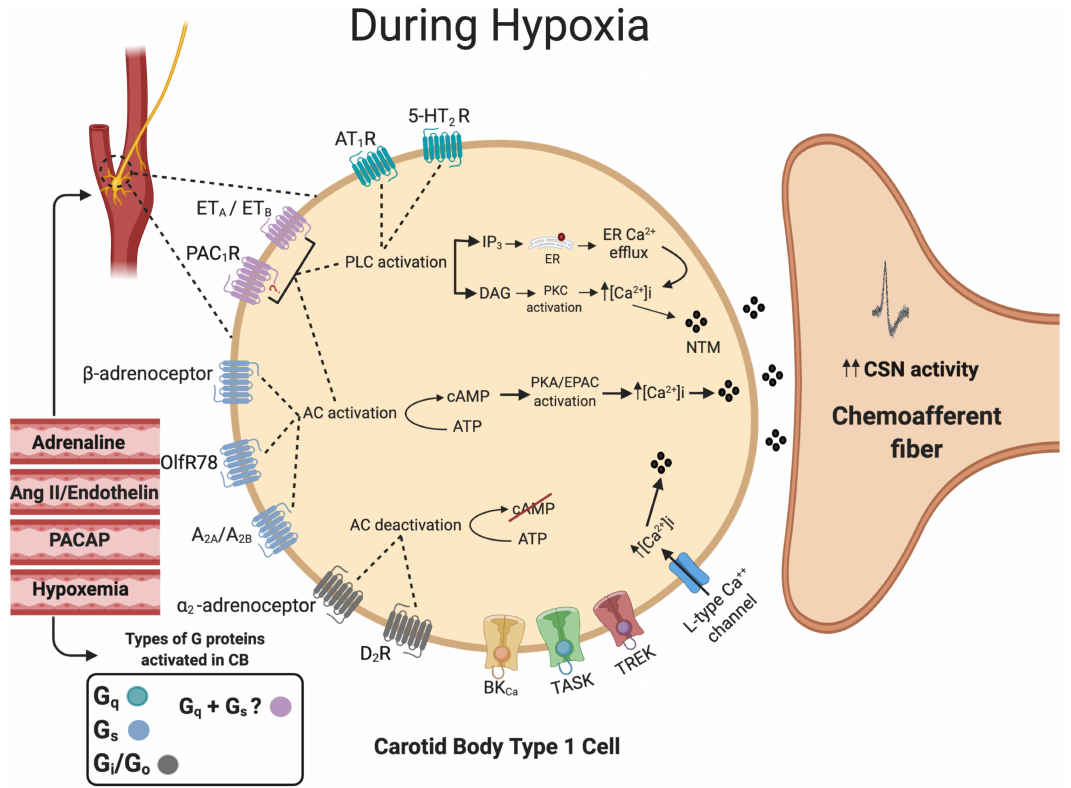
Figure 3. Summary of G-protein signaling in the carotid body type I cell. The activation of G q -protein-coupled receptors (Green) activates phospholipase C (PLC), which in turn leads to the formation of both inositol trisphosphate (IP 3 ) and diacylglycerol (DAG). IP 3 will bind to the endoplasmic reticulum (ER), causing ER Ca 2 + e ffl ux. DAG will activate protein kinase C (PKC). The activation of G s -protein-coupled receptors (Blue) will activate transmembrane adenylyl cyclase (tmAC), leading to an increase in intracellular cyclic adenosine monophosphate (cAMP)